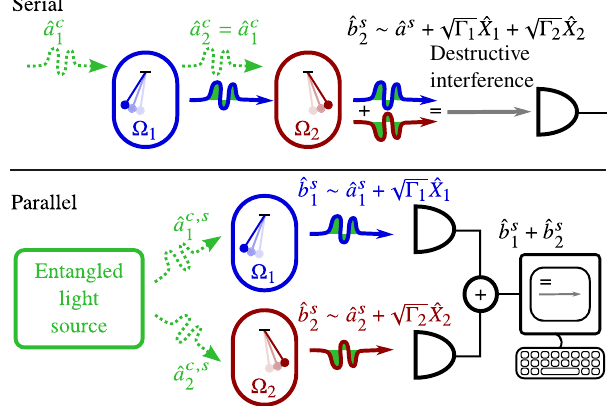
FIG. 1. Basic single-pass topologies for quantum-noise- evading joint measurements on two localized oscillators (pendula; see Sec. I for candidate systems) by means of traveling meter fields (wiggly arrows). In the serial topology, the (stochas- (green dashed arrows) on the two localized tic) QBA forces ∝ ˆ a c j = ˆ a c (in the absence of oscillators are perfectly correlated ˆ a c 2 1 optical losses) simply due to the fact that the same itinerant field is probing the two subsystems. The QBA responses (thick arrows with green filling) of both oscillators are mapped into ˆ of the output light. These contributions the phase quadrature b s 2 will interfere destructively, assuming the counter-rotating frequency configuration (cid:2) 1 = − (cid:2) 2 with matched light- oscillator coupling rates (cid:6) 1 = (cid:6) 2 . In the parallel topology, a source of entangled light correlates the QBA forces , ˆ a c ] > 0 of the two meter fields and anticorrelates Cov[ ˆ a c 1 2 , ˆ a s ] < 0 so that the measurement imprecision noises Cov[ ˆ a s 1 2 both interfere destructively when the two output photocurrents are combined in postprocessing, again provided that (cid:2) 1 = − (cid:2) 2 and (cid:6) 1 = (cid:6) 2